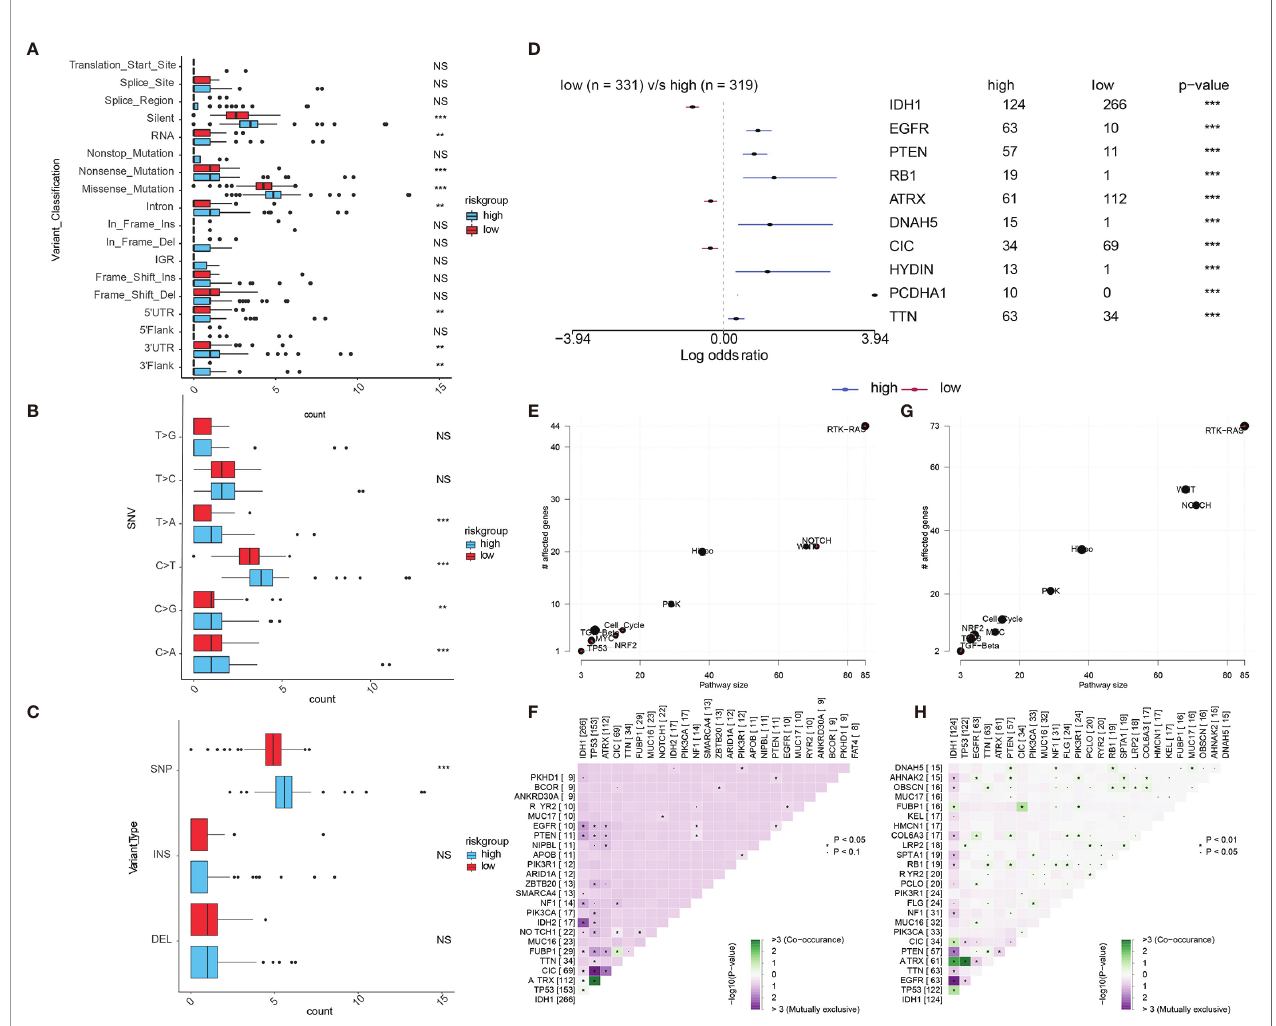
FIGURE 5 | Landscape of somatic mutation in APOBEC3B high and APOBEC3B low groups. (A – C) the comparisons of mutation frequencies of (A) every mutation type classi fi ed by effects, (B) SNVs, (C) INDEL and SNP. (D) Forest plot shows the top 10 most signi fi cantly differentially mutated genes between two groups. Common carcinogenic pathways in (E) APOBEC3B low and (G) APOBEC3N high group. The heatmap indicates the mutually exclusive mutations and co-occurring of the frequently mutated genes in (F) APOBEC3B low and (H) APOBEC3N high groups. NS, Not Statistically Signi fi cant; *P < 0.05; **P < 0.01; ***P < 0.001; ****P <